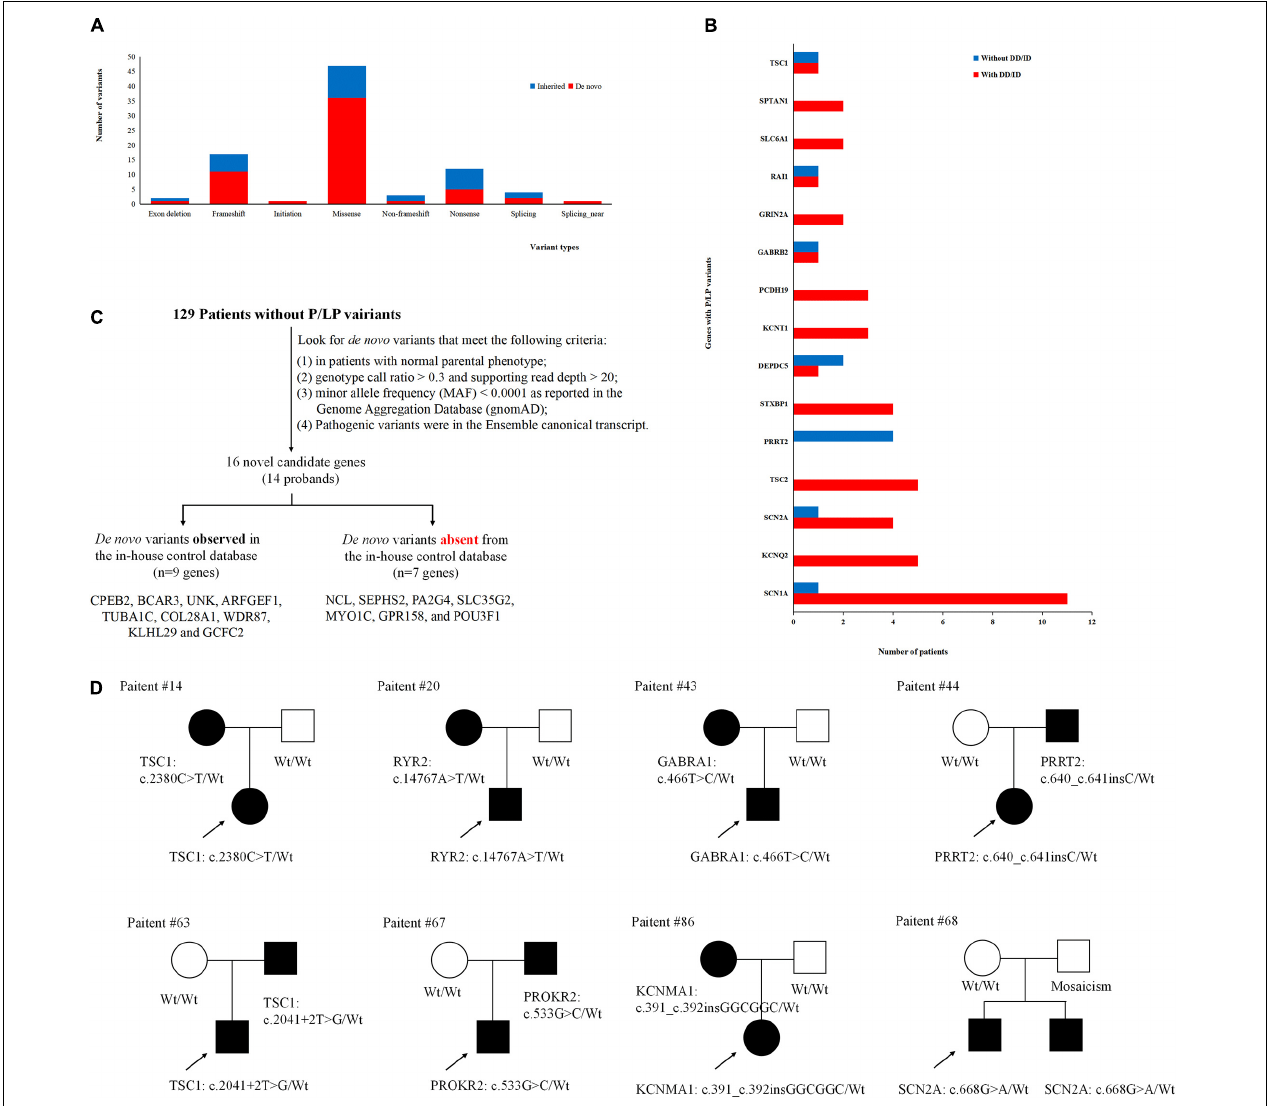
FIGURE 3 | Gene variants analysis. (A) The number of different variant types observed in patients. (B) Identification procedure of candidate pathogenic de novo variants. (C) Distribution of recurrent ( ≥ 2 patients) genes with pathogenic or likely pathogenic variants in the groups of epilepsy with DD/ID and without DD/ID. and (cid:4) represents affected individuals; arrow represents probands; wt represents (D) The diagram of epilepsy pedigrees. ◦ represents female; (cid:3) represents male; wild (cid:32)